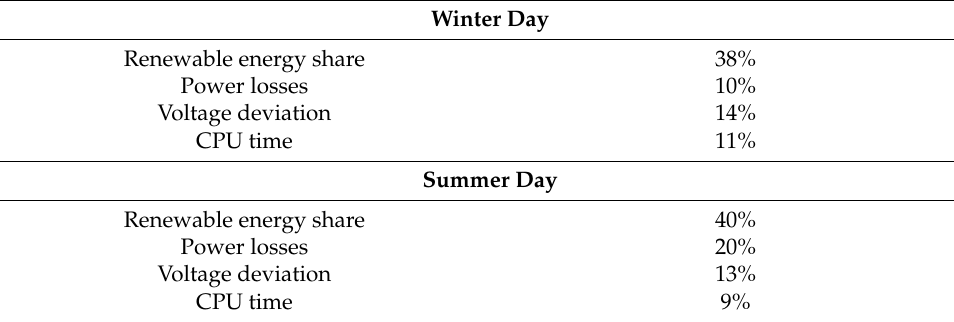
Table 3. Error between CVO and TLBO in %.